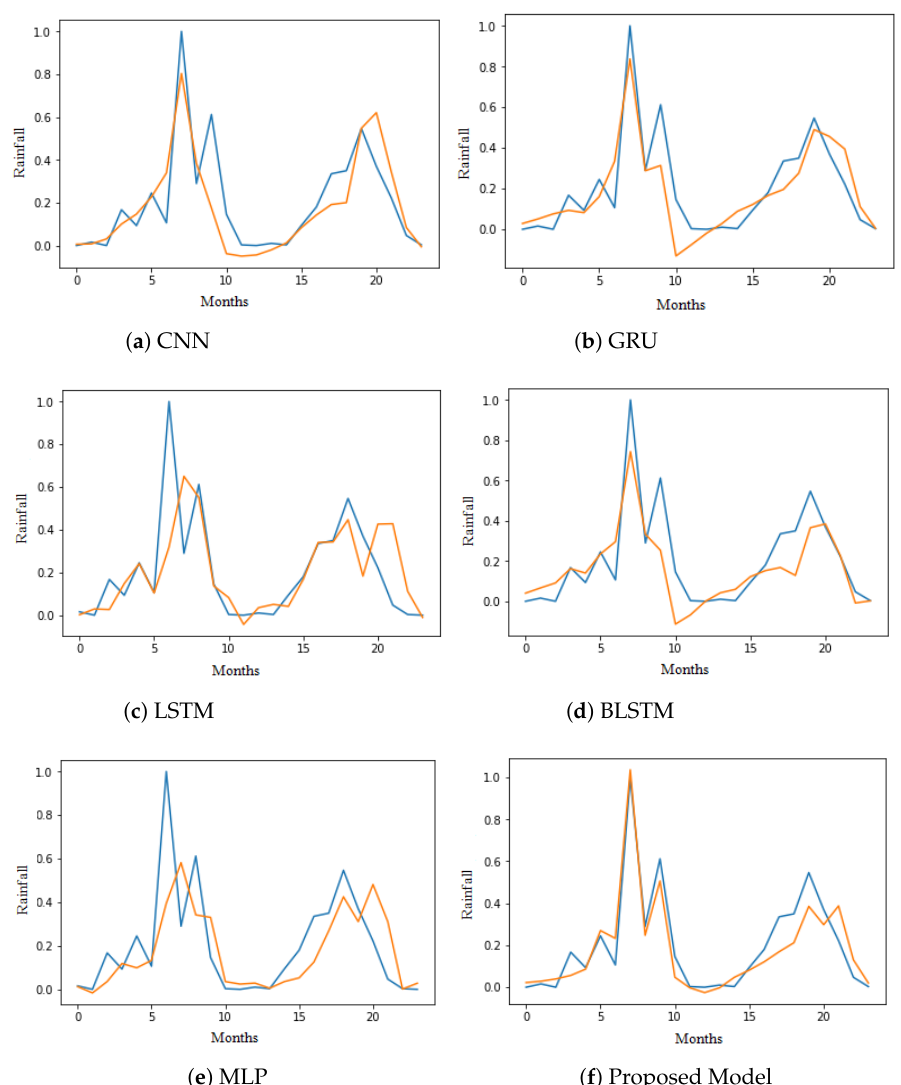
Figure 7. The plots of actual monthly rainfall values over Simtokha collected from NCHM and predicted rainfall values for the years 2016 and 2017, where the x-axis and y-axis represent months and monthly rainfall values (scaled) respectively. The blue line shows the actual values and the orange line shows the predicted values. Subfigure ‘a’ shows that CNN is not able to predict the peak monthly rainfall values correctly. Results of recurrent neural networks shown by subfigure ‘b’, ‘c’ and ‘d’ are better than that of MLP (subfigure ‘e’). Subfigure ‘f’ shows that the proposed model is able to generalize better and gives the best